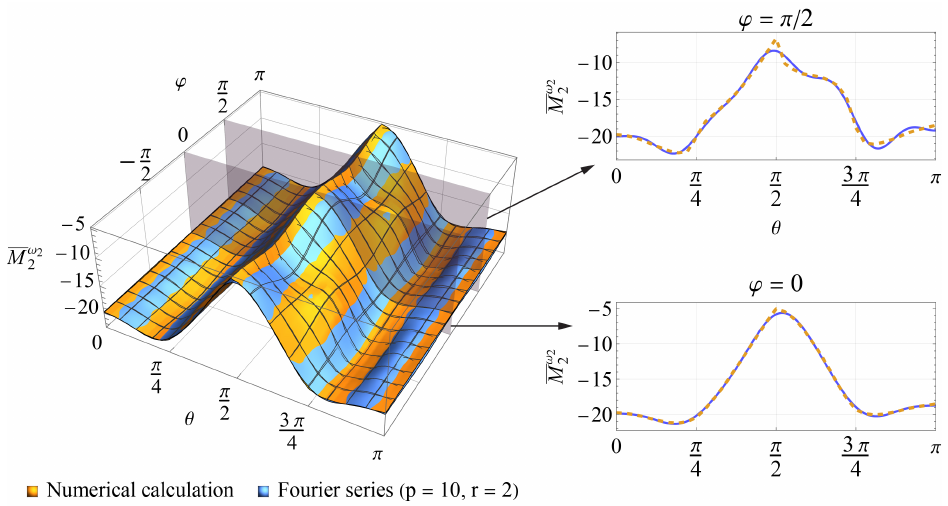
Figure 5. Coefficient ¯ M ω 2